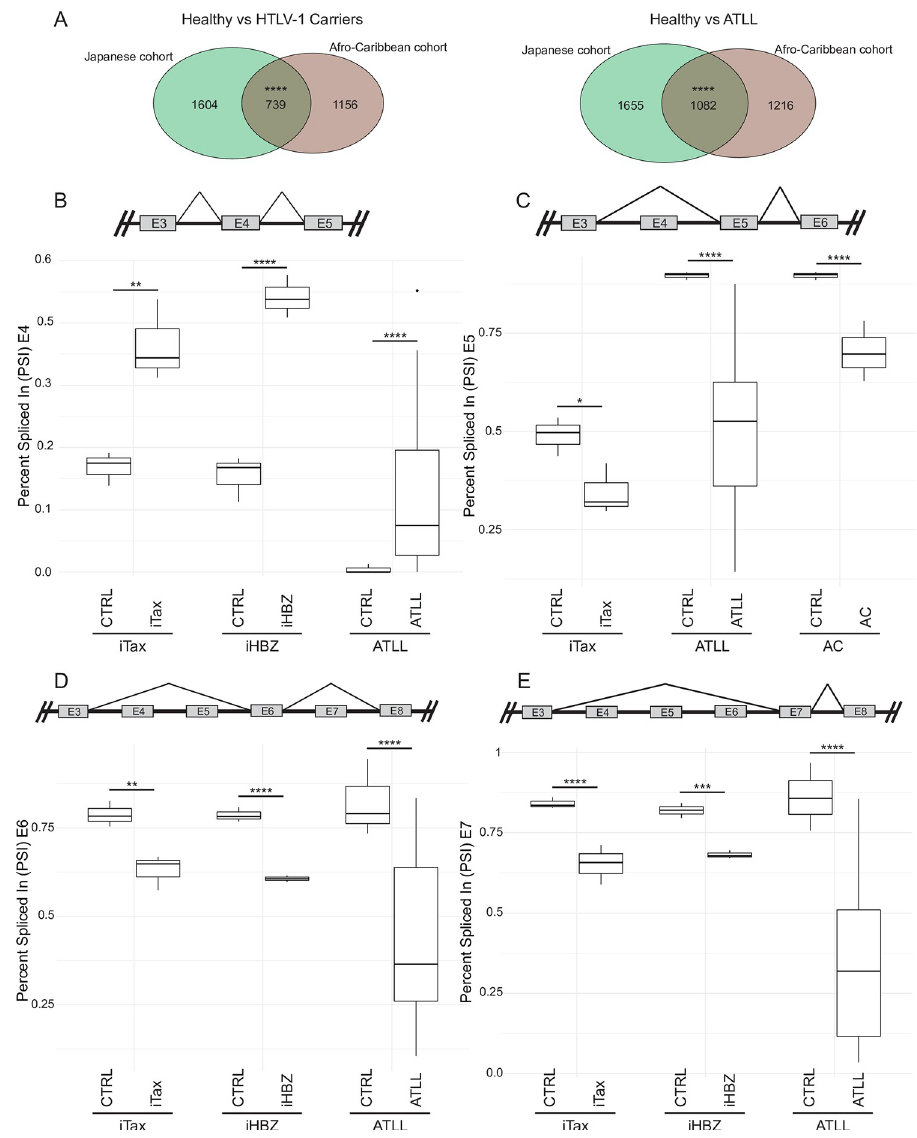
Fig 7. Alternative splicing events affecting PTPRC exons 4 to 7. (A) Venn diagrams showing genes affected by ASEs shared between the two patient cohorts, in carriers (left) and ATLLs (right). Significant overlap between HTLV-1 carriers (p = 2.57e-105) and ATLL patients (p = 1.97e-171) of both cohorts calculated by hypergeometric test. (B-E) Box plots of PSI values of AS exons from significant SEs detected on exons 4 to 7 of PTPRC in the Japanese cohort. A diagram representing the regulated splicing event is shown above each graph. (B) Increased inclusion of exon 4. Decreased inclusion of exon 5 (C), 6 (D) and 7 (E). PSI values for each replicate and event were computationally calculated by rMATS (n = 3 except for ATLL patients where n = 35). FDR of p-values calculated with rMATS by likelihood ratio test. p-value thresholds depicted as follows: � p < 0.05, �� p < 0.01, ��� p < 0.001, ���� p < 0.0001. See also S6 Fig and S3